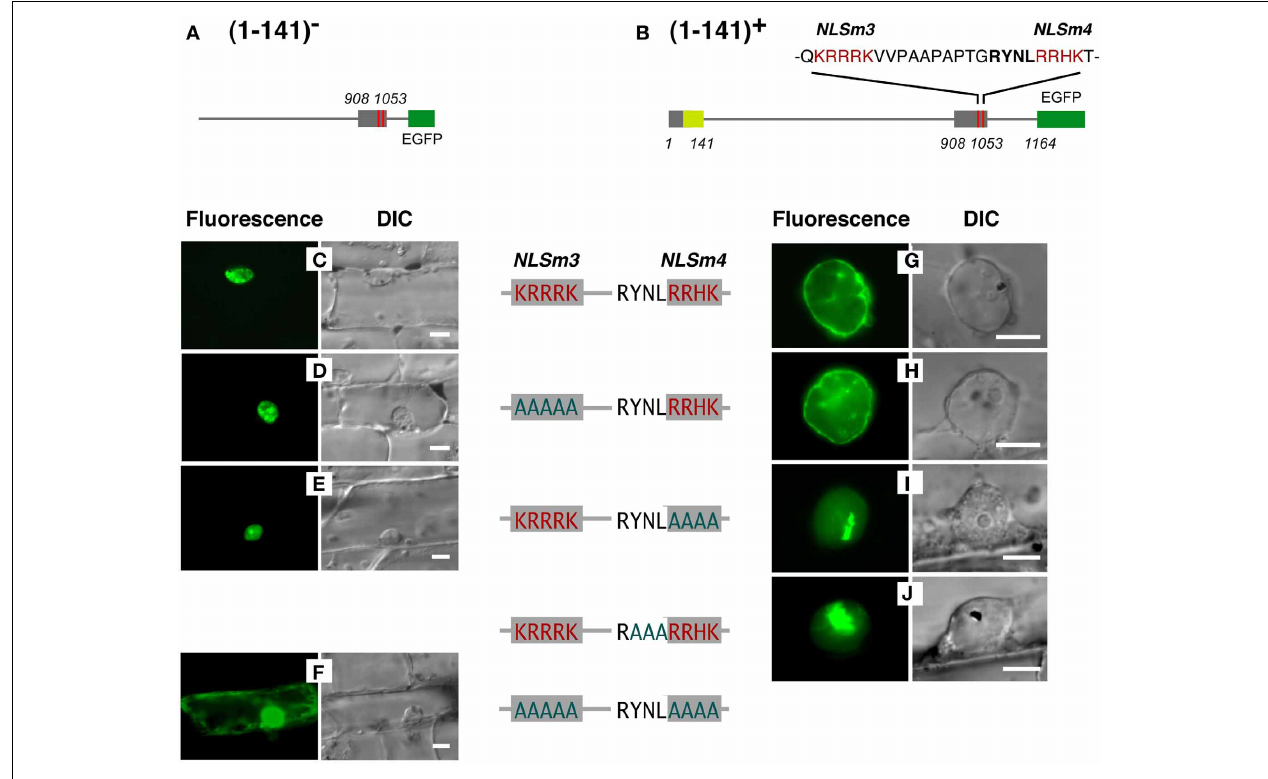
FIGURE 6 | Replacement of amino acids in YNL and/or RRHK with (A) cancels localization of a DcNMCP1-derived protein region to the nuclear periphery. Effects of amino acid replacements were examined, using constructs with (G–J) or without (C–F) the